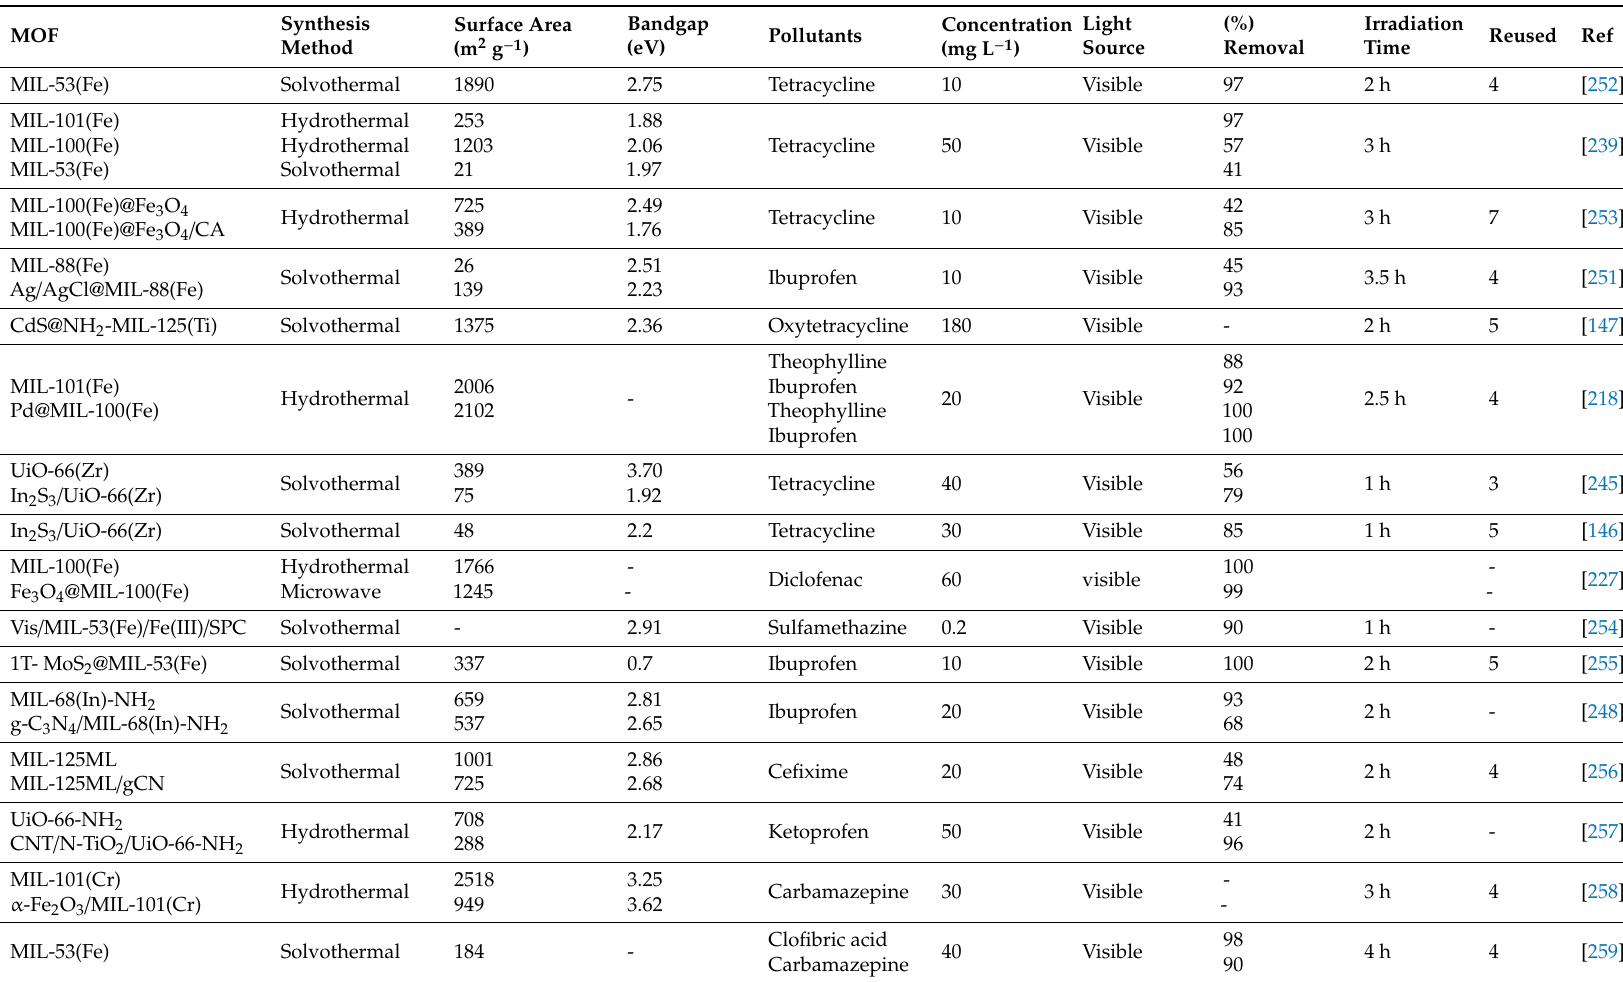
Table 6. MOFs and composites employed for photocatalytic degradations of pharmaceutical drugs from